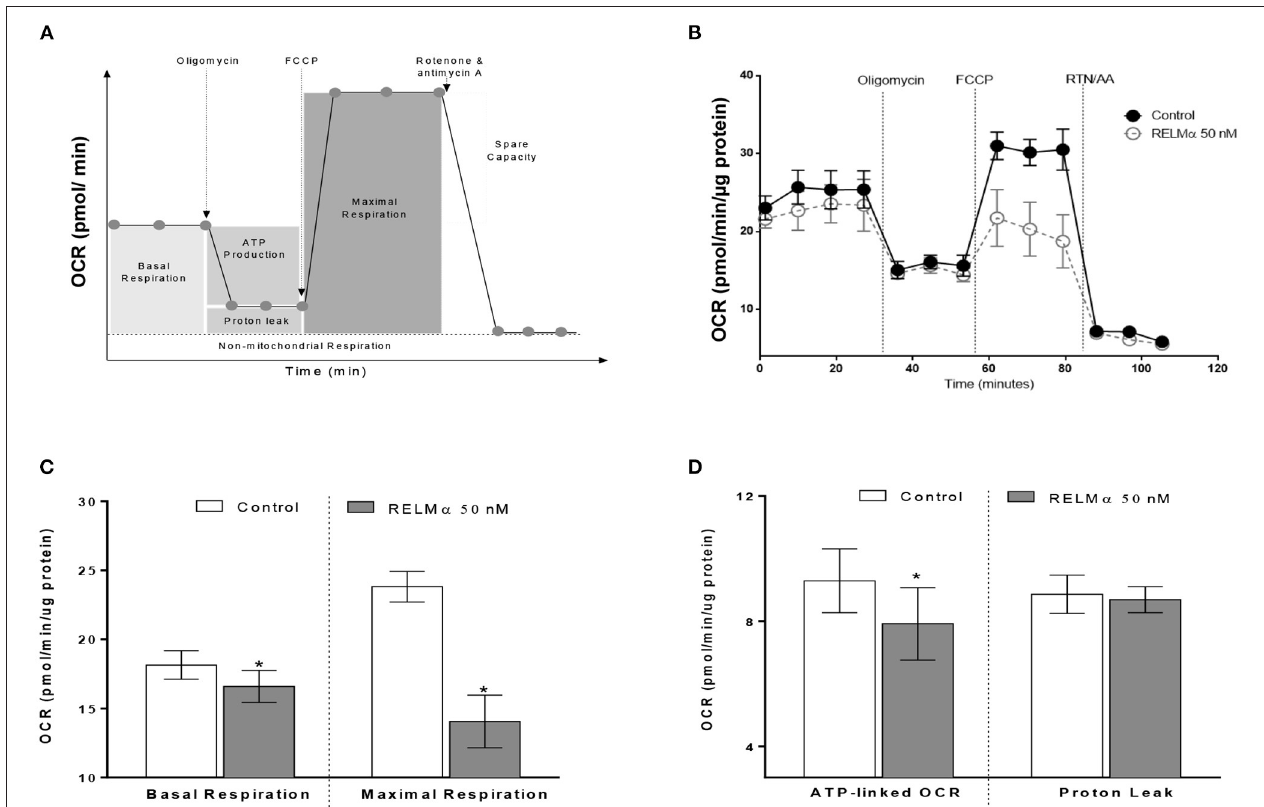
FIGURE 2 | Neonatal rat cardiomyoctyes (NRCMs) challenged with RELM α exhibit a decreased oxygen consumption rate (OCR). (A) Schematic diagram of OCR kinetics. (B) OCR profile in control and RELM α -treated cardiomyocytes. After four baseline measurements, oligomycin (1 µ M, ATP-synthase inhibitor), FCCP (2 µ M, electron transfer chain accelerator), and a combination of rotenone (0.5 µ M, Complex I inhibitor) and antimycin A (0.5 µ M, Complex III inhibitor) were injected into the NRCMs at the indicated times for assessment of basal mitochondrial respiration, ATP-linked OCR, proton leak, maximal respiration, and reserve capacity. (C) OCR based basal and maximal respiration in control and RELM α -treated cardiomyocytes. (D) OCR based ATP-linked OCR and proton leak measurement in cultured cardiomyocytes. n = 5 per group. * p < 0.05 vs. control